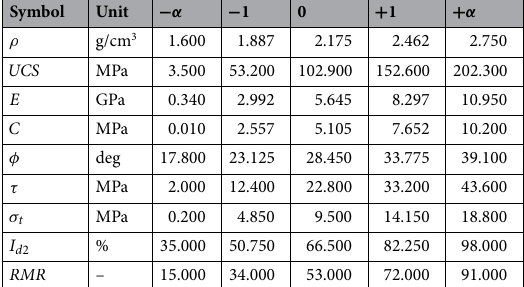
Table 2. Coded and actual levels of input variables.